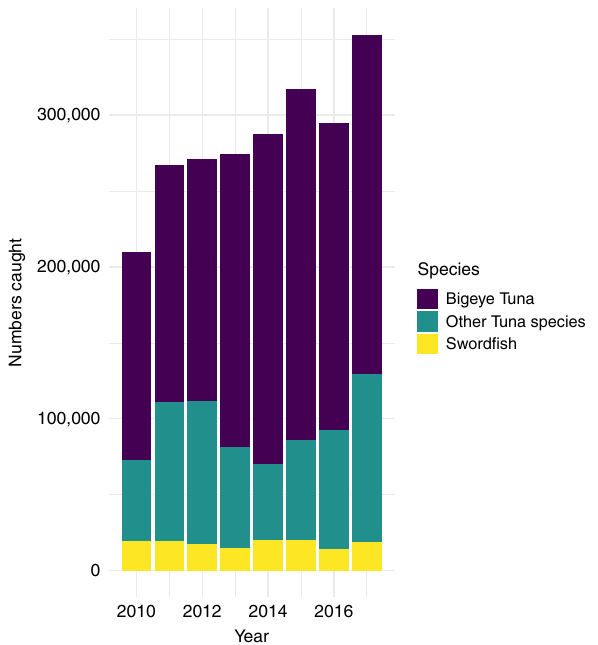
Fig. 2 Total catch by year for commercial pelagic fi sheries. Source: Annual hawaii limited access longline logbook summary reports from 2010 to 2017. Data is from All Sets (Tuna and Sword fi sh) and All Areas (inside monuments, inside and outside U.S. EEZ, etc.). The total catch is color- coded by species: Bigeye Tuna in dark purple, Other Tuna Species in dark teal, and Sword fi sh in yellow. Source data are provided as a Source Data fi le.